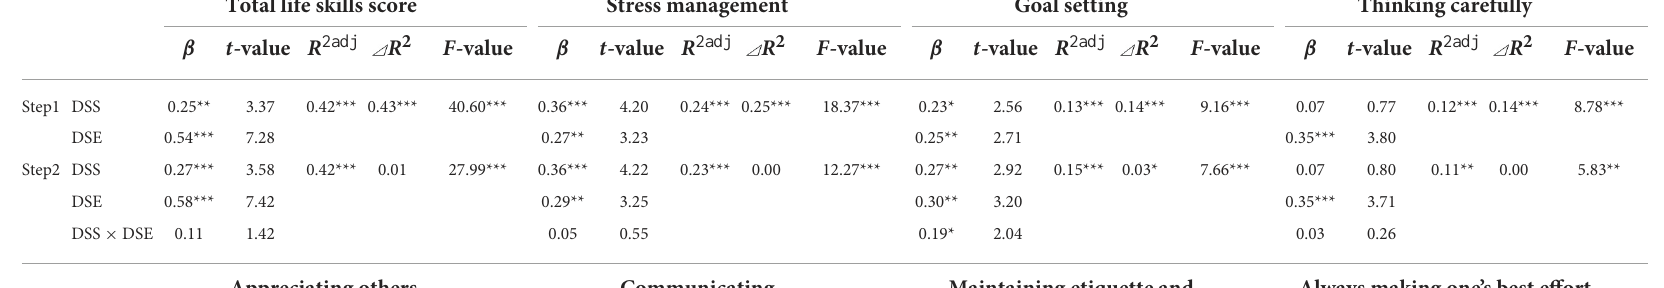
TABLE 2 Hierarchical regression results of total life skills and subscales in the pre-action